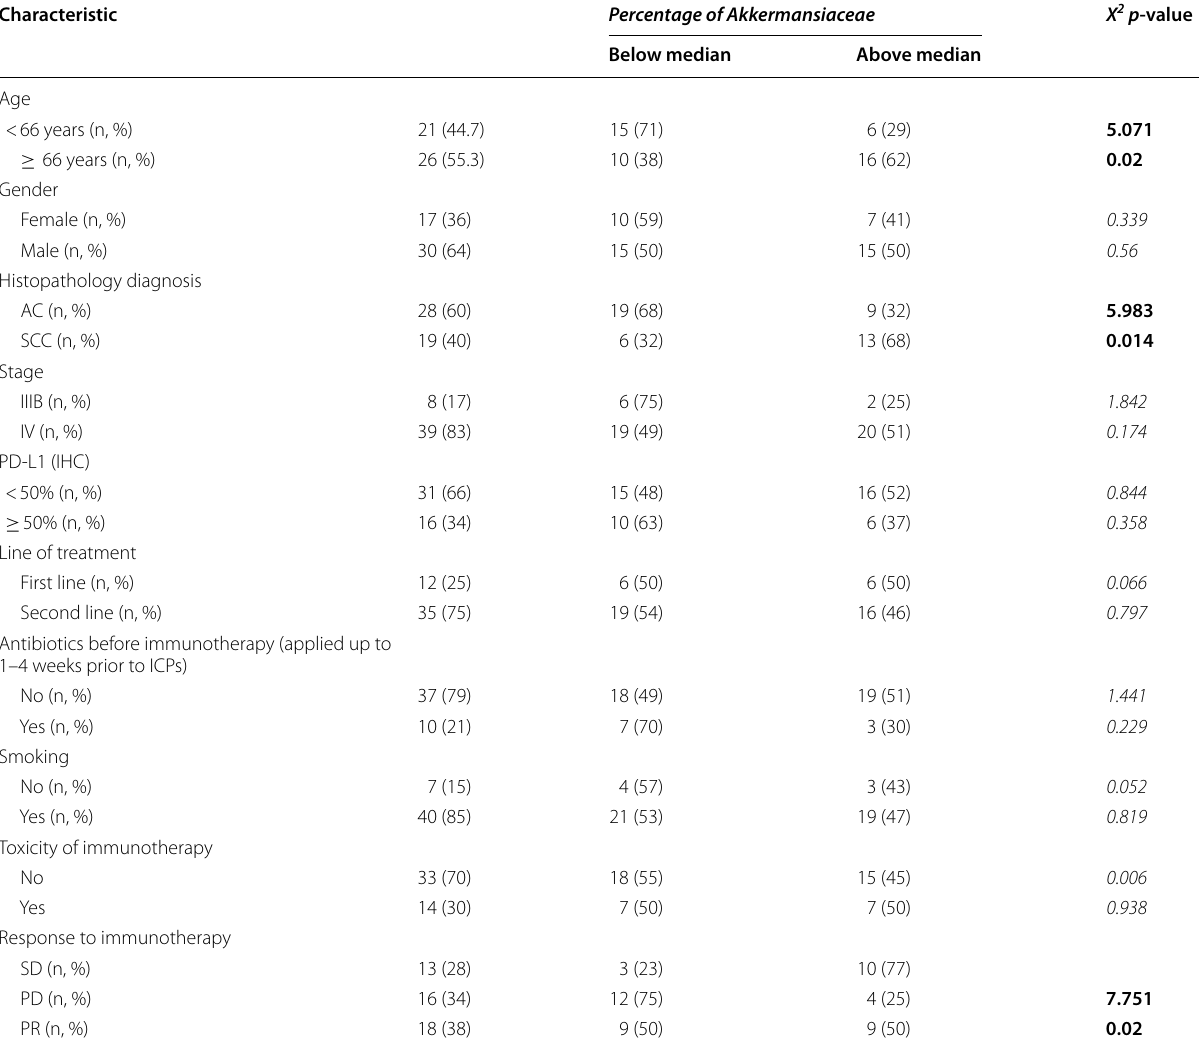
Table 1 Clinical and demographic characteristic of the patients included in the